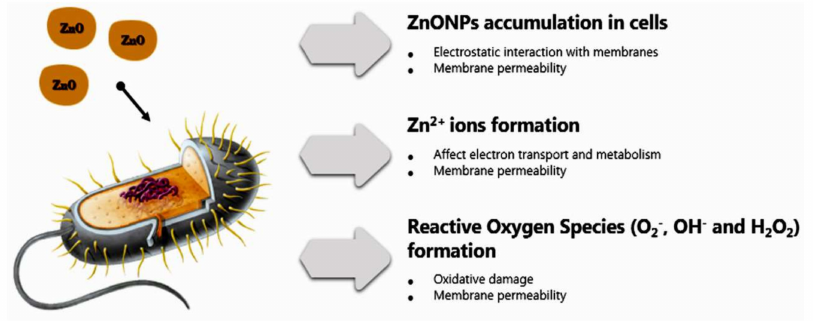
Figure 7. Possible mechanisms of ZnONPs antibacterial potentiality.